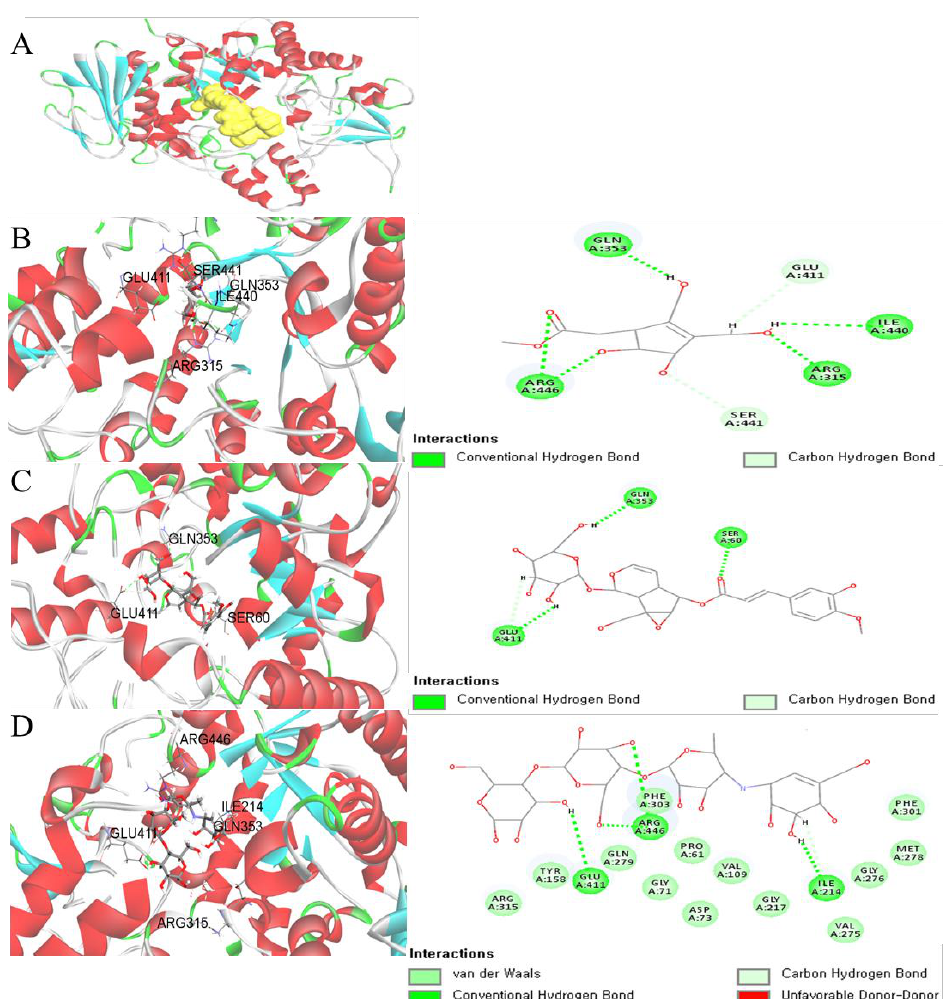
Figure 5. Binding mode of 3 , 9 , and acarbose in the active site of a-glucosidase ( A ). Receptor–ligand interaction of compounds 3 ( B ), 9 ( C ), and acarbose ( D ) on 2D and 3D diagram.